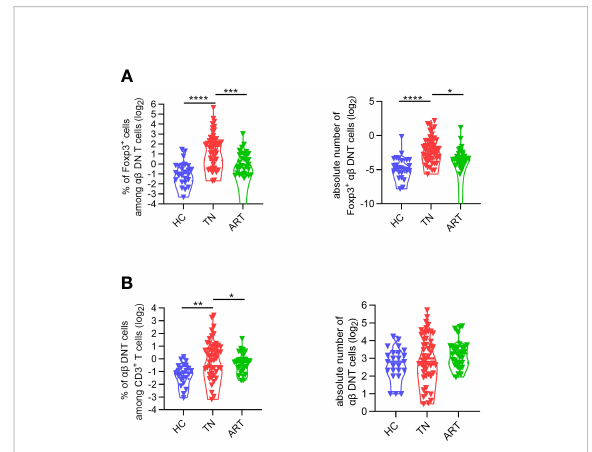
FIGURE 5 The frequency of Foxp3 + DNT cells was partly restored after ART. (A) Violin plots of the frequencies (left) and absolute numbers (right) of DNT cells from healthy donors, TNs with baseline CD4 + T cell count < 200 cells/µl, ARTs who have been treated more than 4 years with matched nadir CD4 + T cell count. (B) Comparison of Foxp3 + DNT cells frequencies (left) and absolute numbers (right) in healthy donors, TNs, ARTs. P values were obtained by the Kruskal – Wallis test, followed by Dunn ’ s multiple comparisons test. * P < 0.05, ** P < 0.01, *** P < 0.001, **** P <